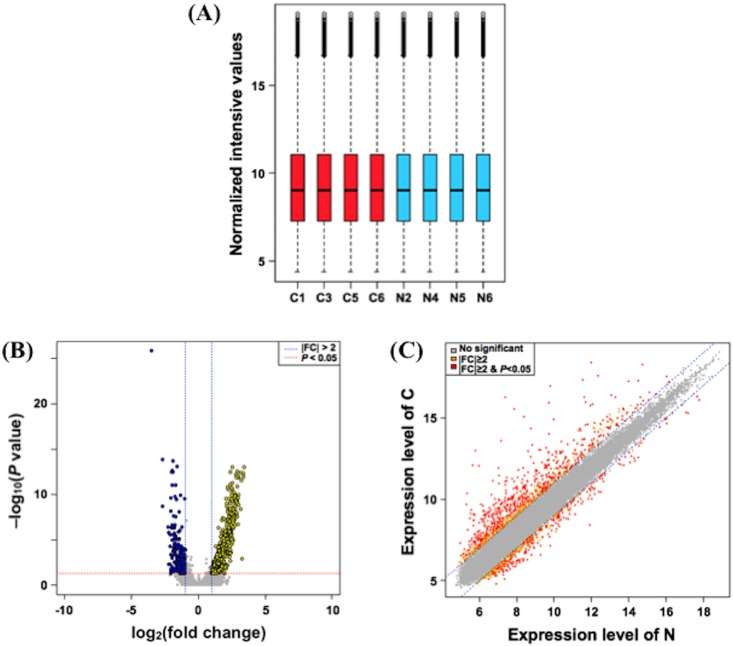
Expression profiles of genes in bronchial smooth muscle tissues of the repeatedly antigen-challenged (C) and normal control (N) mice.Total RNA sample of each mouse (4 animals, respectively) was subjected to the microarray analysis as described in METHODS. (A) Box-whisker plots of genes show the distribution of intensities from all samples. (B) Volcano plots show variation in gene expression. The vertical lines correspond to 2.0-fold up- and down-regulations. The horizontal line represents a P-value of 0.05. (C) Scatter plots show variation in gene expression. FC: fold change.